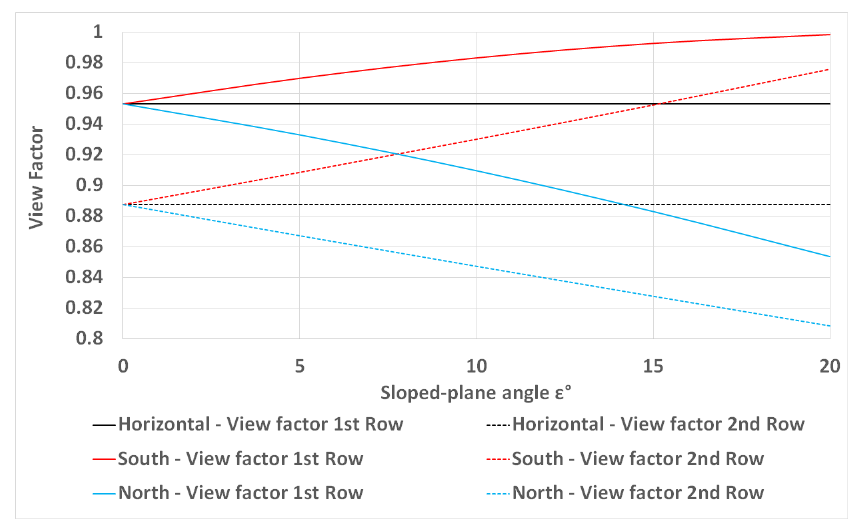
(see Equations (3), (7) and (10).